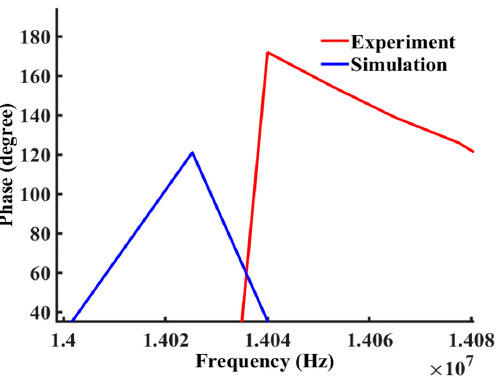
Figure 9. Comparison between simulated (Blue) and measured (Red) linear magnitude frequency response for the device (with Cr IDTs only) from 13 MHz to 16 MHz. ( a ) Simulated linear magnitude frequency response of the design. ( b ) Measured linear magnitude frequency response from the fabricated device.